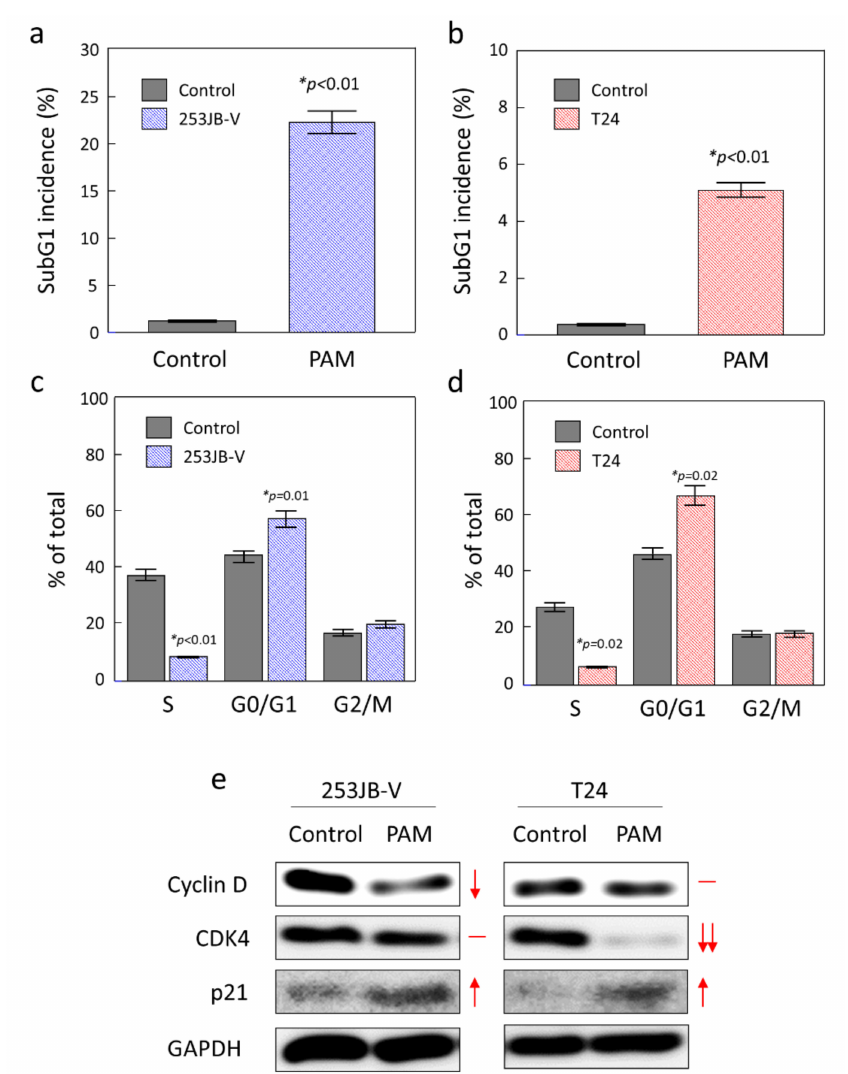
Figure 3. Changes in the bladder cancer cell cycle induced by PAM. Incidence in the sub G1 phase for ( a ) 253JB-V and ( b ) T24 bladder cancer cells. Percentage of cell population in each stage of the cell cycle for ( c ) 253JB-V and ( d ) T24 bladder cancer cells. ( e ) Western blot analysis of cell cycle regulatory factors showing up-regulation, down-regulation or no change indicated with up/down arrows or horizontal line, respectively (larger areas of the Western blots are shown in Supporting Materials S2). Control in all figures refers to untreated cells. GAPDH is included as the internal control in the Western